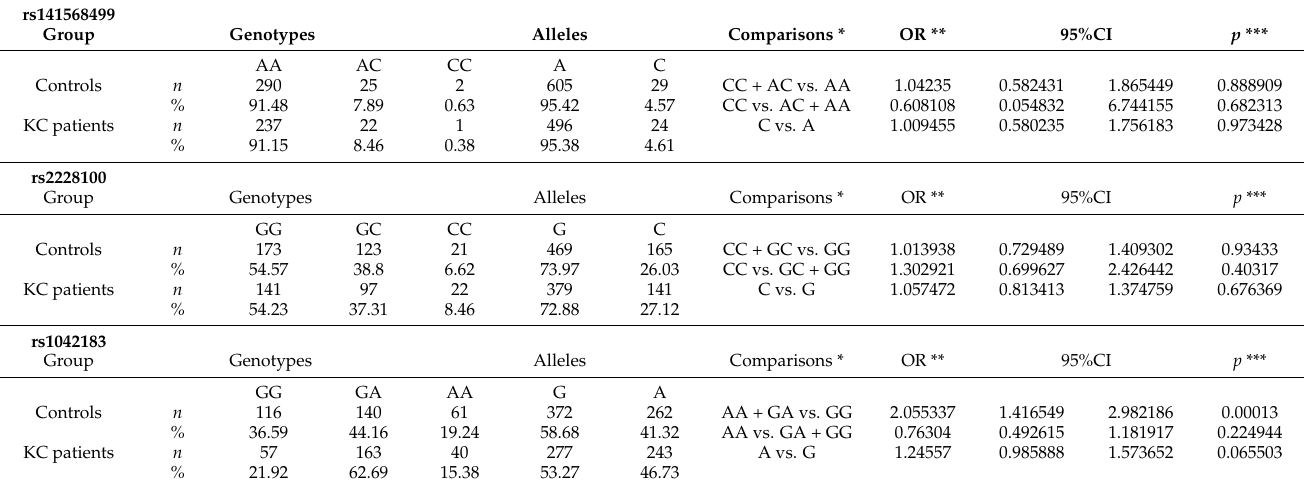
Table 1. Distribution of genotypes and alleles ALDH3A1 gene polymorphisms in the KC patients and the